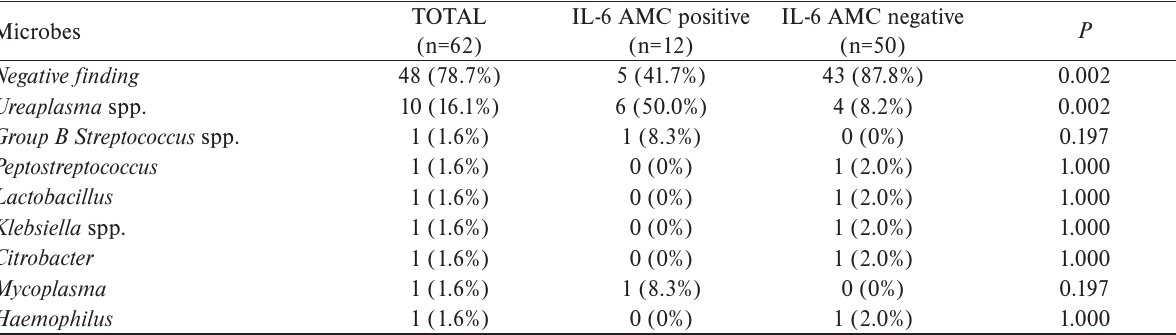
Table 3. Microbes identified in the amniotic fluid from amniocentesis in women with PPROM.